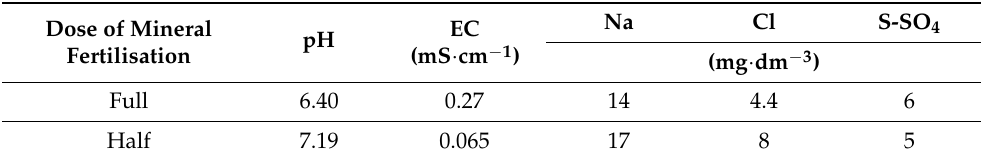
Table 1. The salinity and pH of the soil and the contents of soluble forms of Na, Cl, and S-SO4 in nursery soil (mean value for 2017–2018).